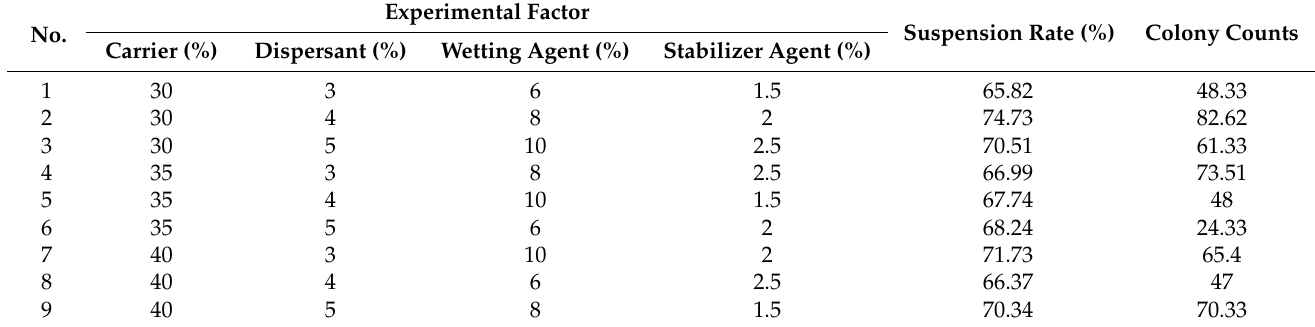
Table 1. The optimization ratio of carrier and additive by the orthogonal test.